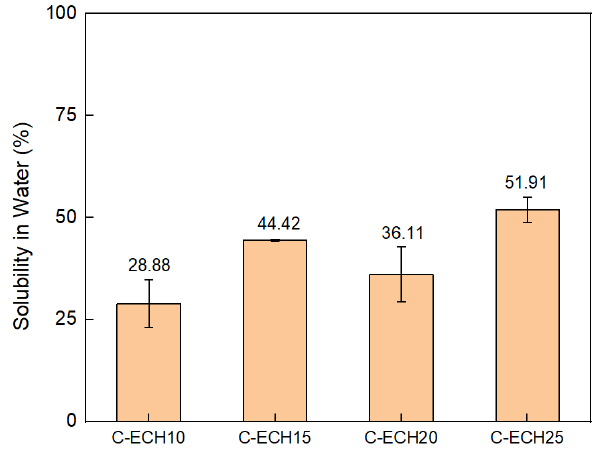
Figure 8. Percentage of the solubility in water of the cellulose bioplastic samples at various ECH concentrations.